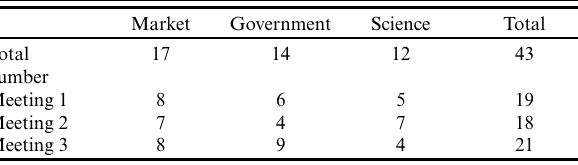
Table 1 . Shadow network members, by stakeholder